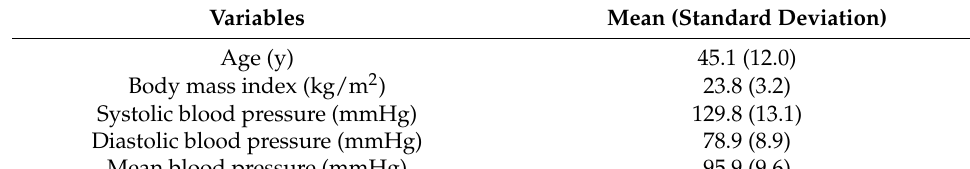
Table 1. Characteristics of subjects at study entry year.